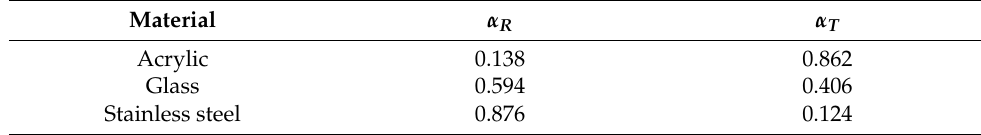
Table 2. The reflection ( α R ) and transmission ( α T ) coefficient of